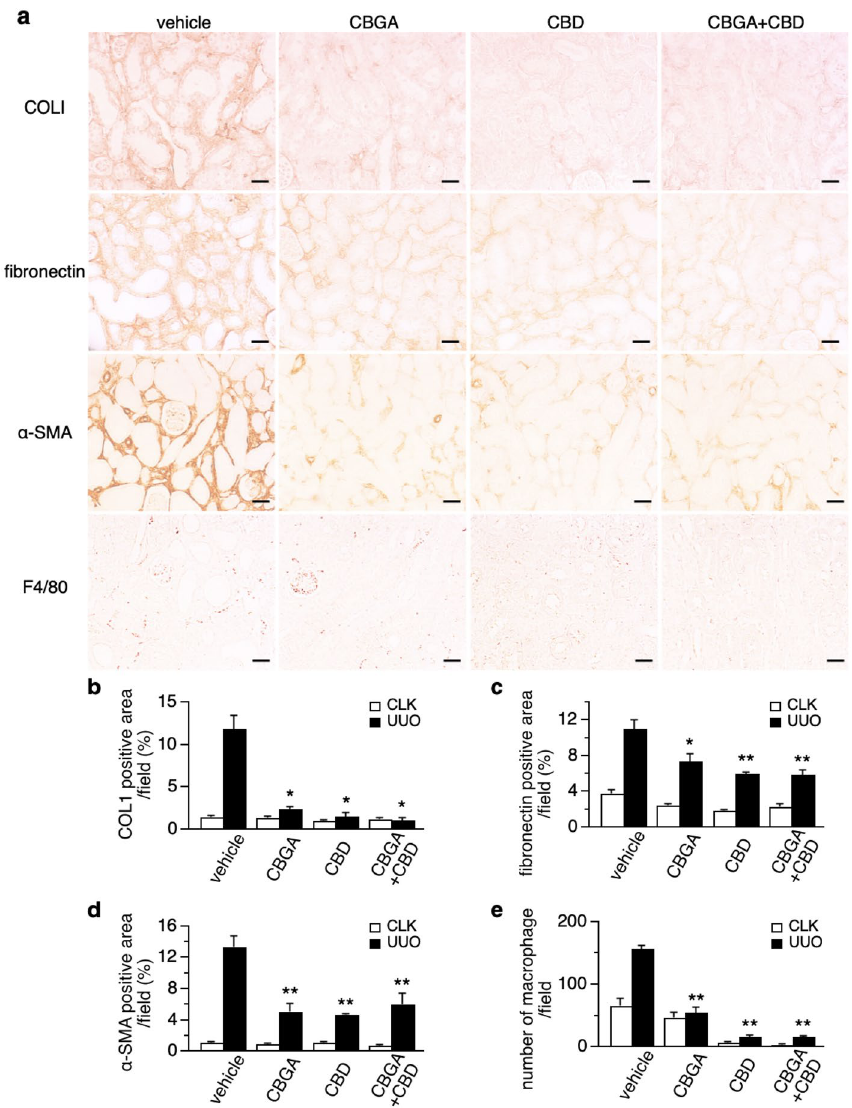
Figure 6. Renal fibrosis is attenuated by CBGA and CBD treatment. ( a ) Representative images of immunostainings for collagen type I, fibronectin, α-SMA and F4/80 from UUO kidneys treated with vehicle, CBGA, CBD and CBGA + CBD (magnification × 200). Scale bars represent 50 µm. (see also Supplementary Fig. S3 for CLK kidneys) ( b–d ) The average percentage of the collagen type I-positive area ( b ), fibronectin- positive area ( c ), α-SMA-positive area ( d ) in CLK (white bars) and UUO kidneys (black bars) with vehicle treatment, CBGA, CBD and CBGA + CBD treatment. The intensity of staining in the interstitium was computed using ImageJ software in 10 representative non-overlapping slides. ( e ) F4/80 antibody was used to detect macrophage on immunostaining, F4/80-positive cells in interstitium were counted as number of macrophages. *p < 0.05, **p < 0.01 vs. UUO kidneys treated with vehicle